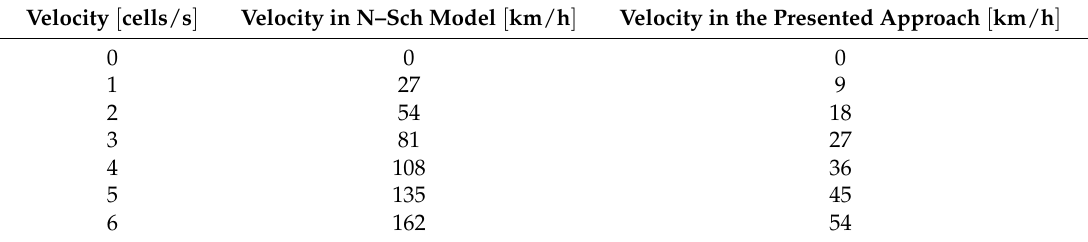
Table 2. Comparison of velocities in the Nagel–Schreckenberg (N–Sch) model and the presented approach. Velocity [ cells / s